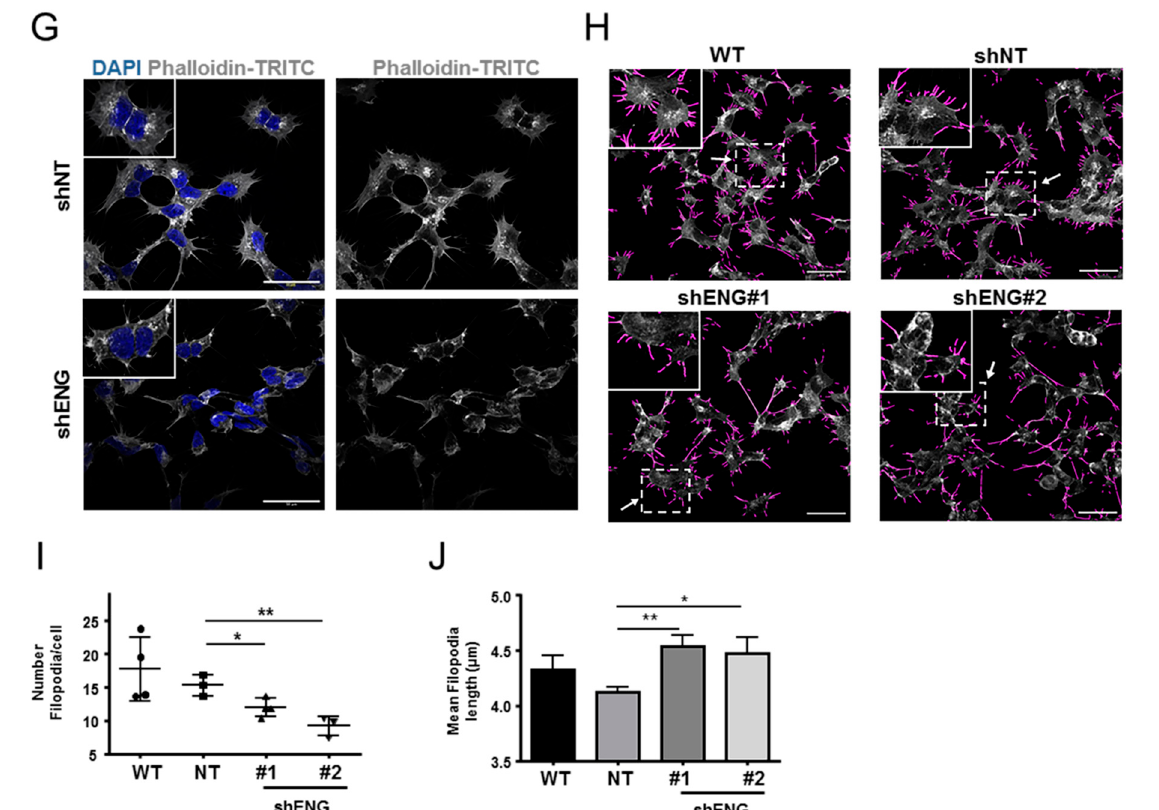
Figure 4. Cell migration and adhesion are positively regulated by ENG in association with actin filaments and filopodia formation in ES cells in vitro. ( A ) Cell migration assay of RM82 shENG cells in Boyden chamber. In the absence of ENG, migration was significantly reduced in comparison to the control condition. ( B ) Cell migration assay from TC71 pENG cells in Boyden chamber. Overexpression of ENG promoted migration, which was statistically significant in one of the clones. ( C ) Cell–substrate attachment assay using RM82 sgMMP14 cells on 20 µg/mL FN for 15 min. Expression of MMP14 significantly impaired attachment on FN. ( D ) Cell attachment assay from the RM82 shENG model performed on 20 µ g/mL FN for 15 min. ENG downregulation was associated with lower adherence to the substrate. ( E ) Cell spreading assay was performed TC71 pENG model on 20 µ g/mL FN for 1 h. Cell spreading was increased in the presence of ENG. ( F ) Quantification of filamentous actin area showed a reduced cytoplasmic location in the ENG-downregulated condition. (Grey scale bar, 50 µ m.) ( G ) IF of actin filament staining by phalloidin-TRITC in RM82 shENG cells. Downregulation of ENG led to actin filament aggregates and disrupted distribution along the cytoplasm. ( H ) IF of actin filaments (gray) and identification of filopodia (purple) by Fiji (FiloQuant) in RM82 WT, shNT, and shENG cells. ( I , J ) The density of filopodia per cell ( I ) and the filopodia length ( J ) were measured by filopodia quantification in RM82 WT, shNT, and shENG cells. Paired ( A , B , D ) and unpaired ( C , E , F ) two-tailed Student’s t -test were used to determine statistical significance (* p < 0.05; ** p < 0.01; and *** p <